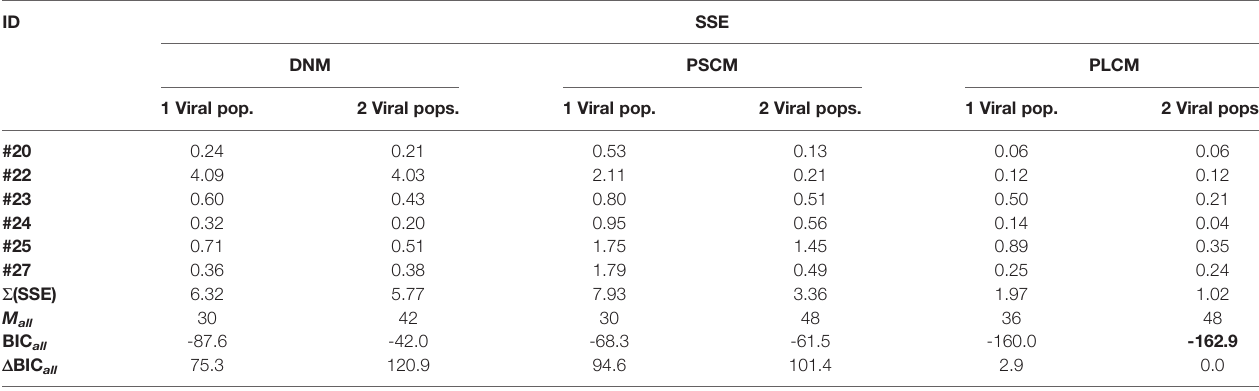
TABLE 4 | Sum of squared error (SSE) and global Bayesian information criterion (BIC all ) values.